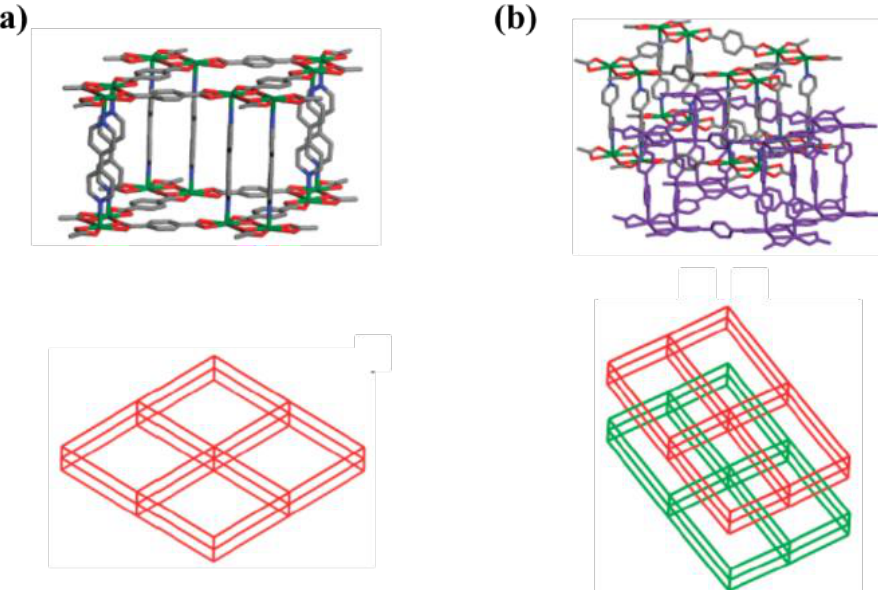
Figure 7. ( a ) Non-interpenetrated structure of [Cd(bipy)(bdc)] formed using low concentration of reactants; ( b ) Interpenetrated structure of [Cd(bipy)(bdc)] formed using high concentration of reactants. Reprinted with permission from [39]. Copyright 2009 American Chemical